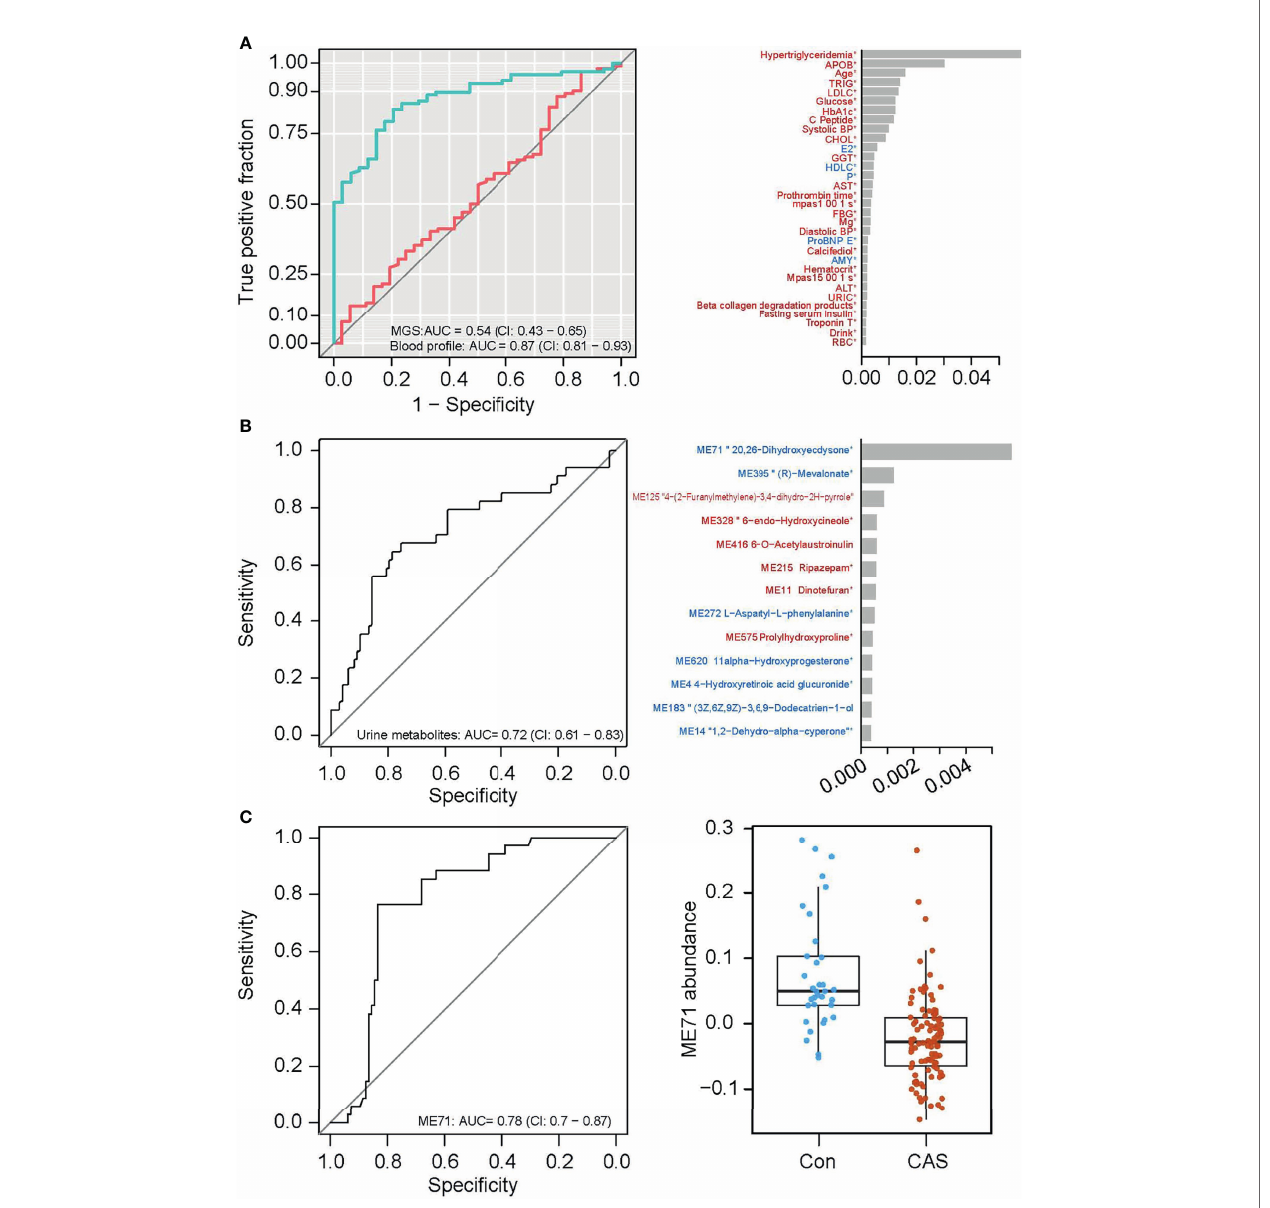
FIGURE 6 | Classi fi cation of carotid atherosclerosis based on the gut microbiome or on the urine metabolome. (A) ROC curves of carotid atherosclerosis classi fi cation based on MGS relative abundances (red) and on the blood pro fi le (green, the left panel), and the top important clinical parameters contributory to the prediction based on blood pro fi le (the right panel). (B) The ROC curve of carotid atherosclerosis classi fi cation based on the urine metabolome (left panel), and the top important metabolite groups in the classi fi cation model (right panel). (C) The ROC curve of carotid atherosclerosis classi fi cation based on one urine metabolite ME71 (the left panel), and abundances of ME71 in the non-carotid atherosclerosis and carotid atherosclerosis groups (the right